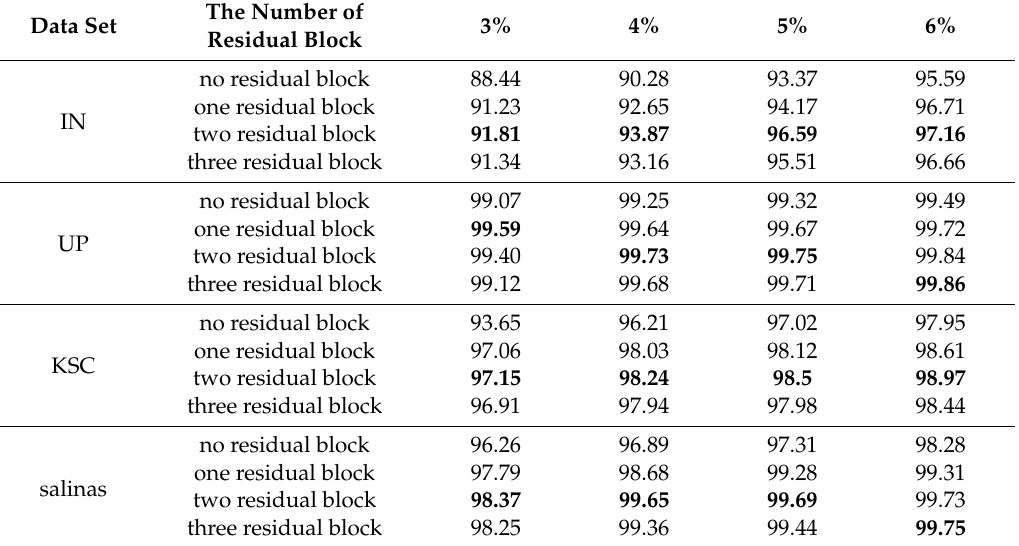
Table 7. The number of residual blocks selection